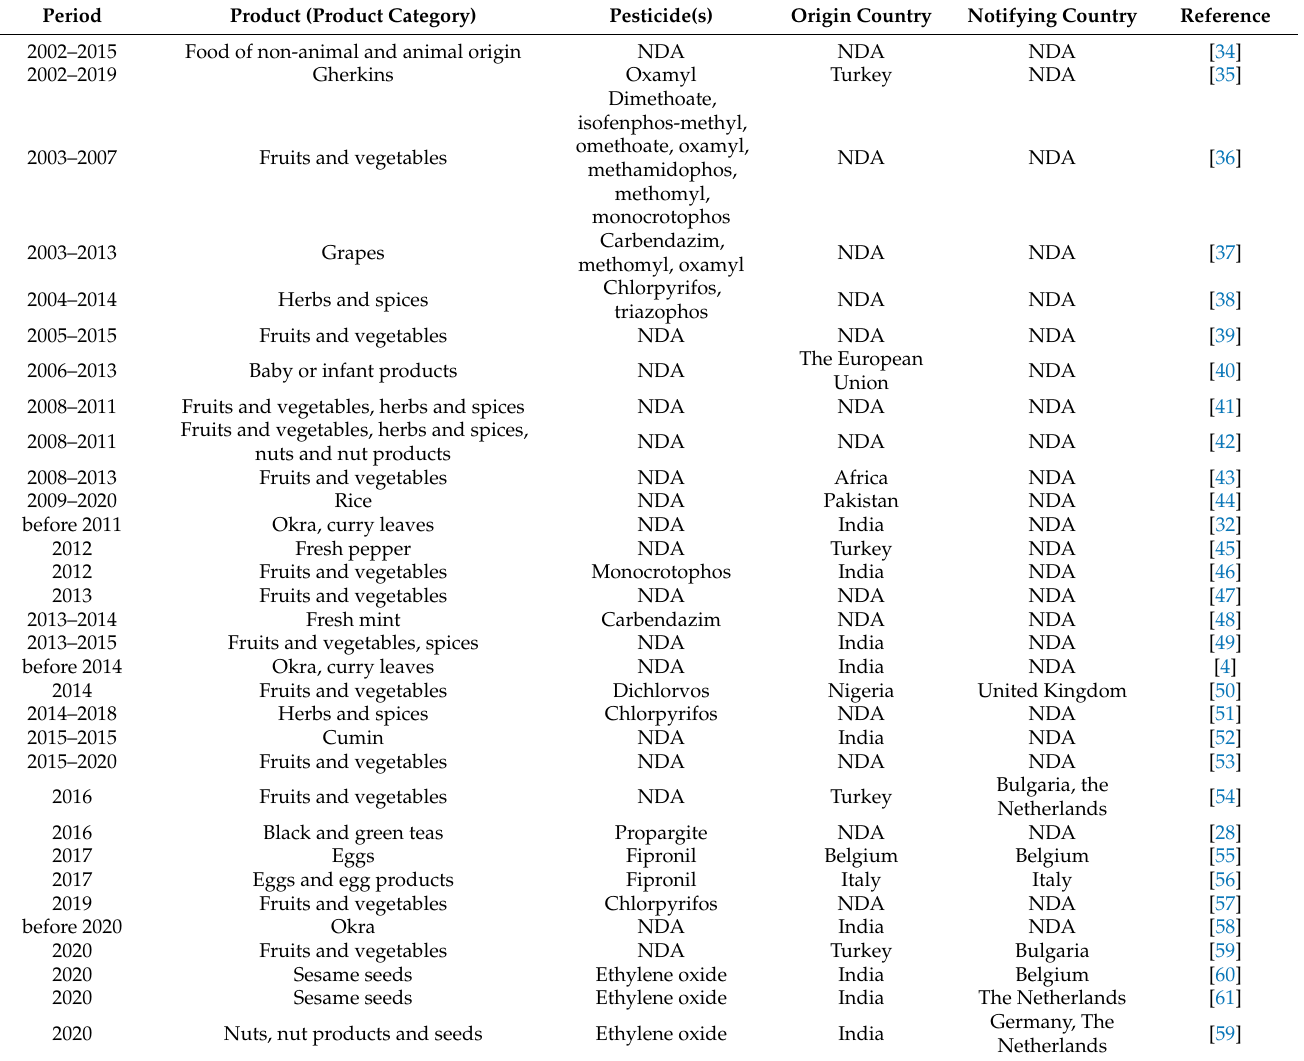
Table 4. Information on notifications of pesticide residues in the RASFF according to different